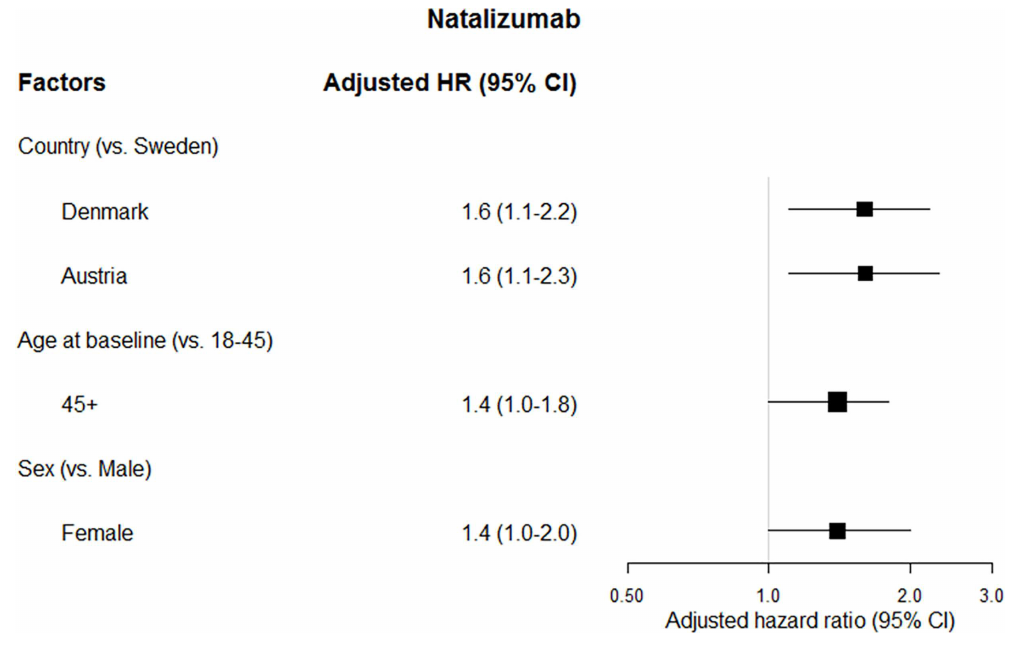
Fig 5. Multivariate risk factors for anti-natalizumab ADA development. (N =